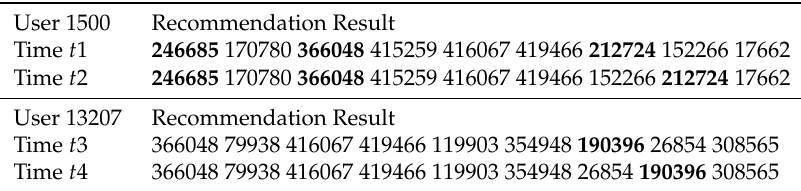
Table 7. The recommendation results of user 1500 and user 13207 at different